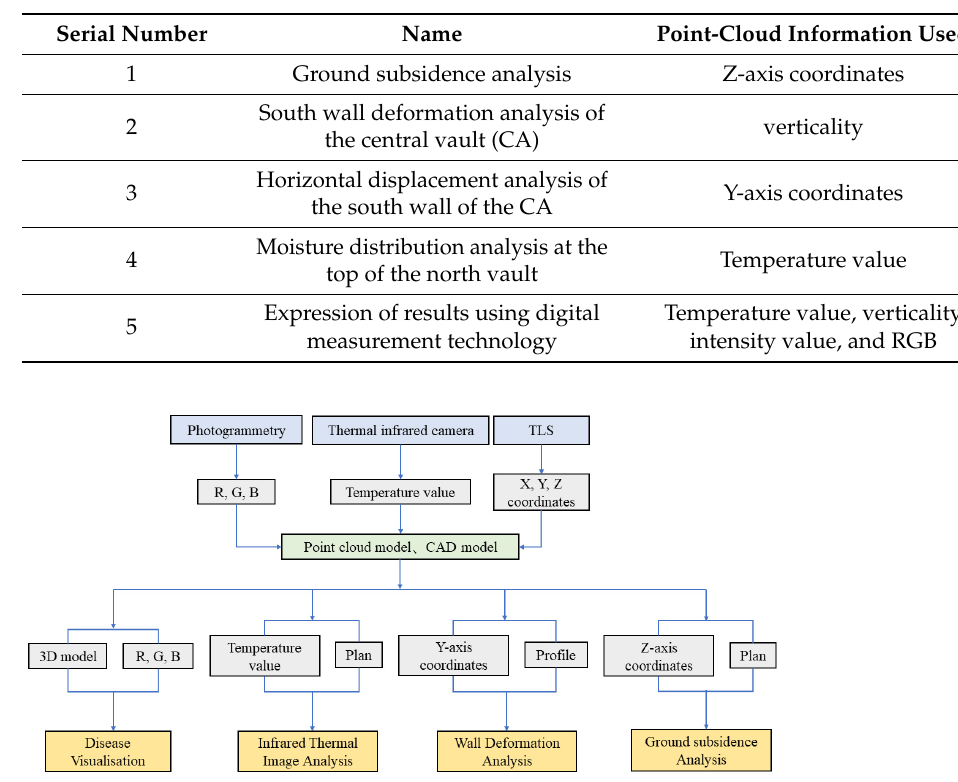
Table 2. Summary table of the point-cloud information used in the graphics representation of this study.